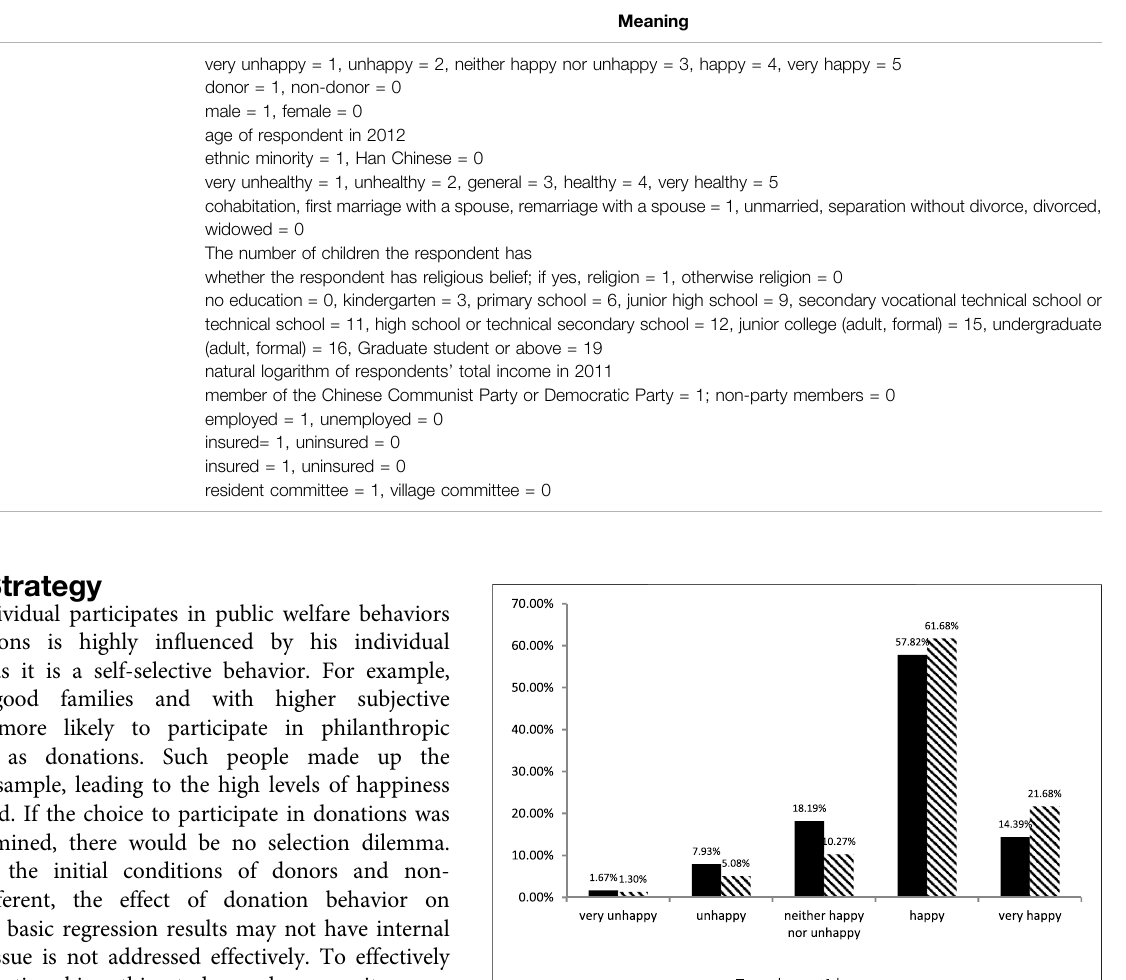
TABLE 2 | Description of control variables.